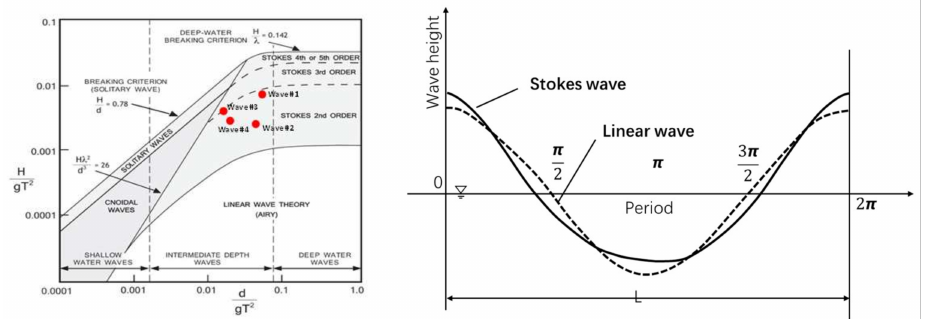
Figure 5. Scope of wave theory. (Floating Body Test Wave #1 with H = 0.1 m T = 1.2 s; Typical annual wave simulation Wave#2 with H = 0.6m T = 5 s; Typhoon Dujuan simulation Wave#3 with H = 3.7 m T = 9.9 s; Typhoon experiments Wave#4 with H = 1.5 m, T = 7.4